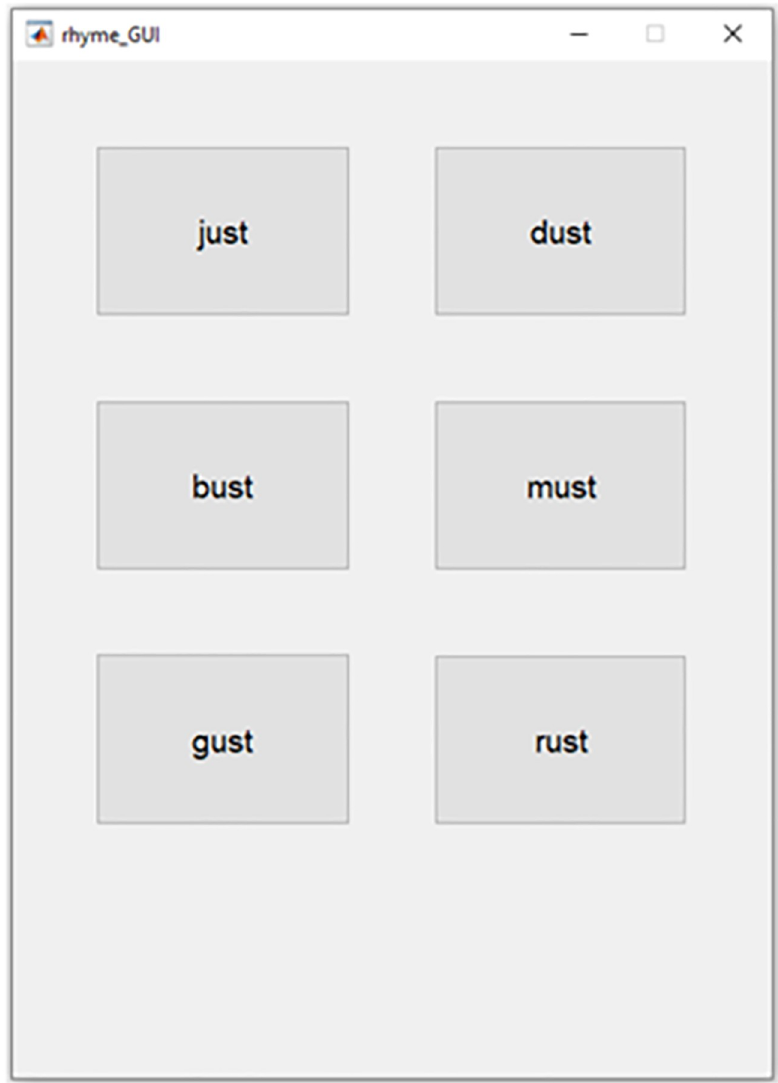
Fig 4. Experiment’s guided user interface. Example of MATLAB’s GUI for a single trial of implementing the Modified Rhyme Test (MRT).